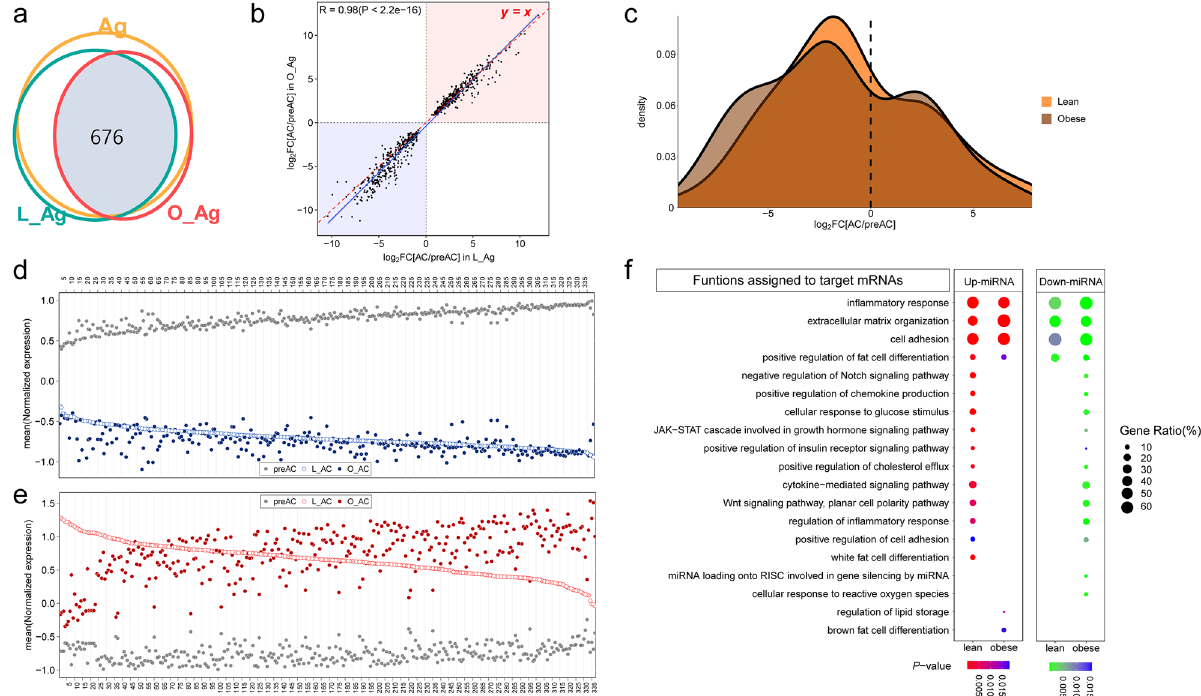
Figure 3. Analysis of DEMs commonly associated with both L_Ag and O_Ag. ( a ) Venn diagram depicting the number of common DEMs ( Q < 0.01 in both L_Ag and O_Ag). The yellow circle represents the Ag_DEMs, and the green and red circles represent the L_Ag-associated DEMs and O_Ag-associated DEMs, respectively. The light blue shaded region represents the overlapping area between each comparison group. ( b ) Scatter plot for common DEMs. The upregulated and downregulated DEMs are shaded red and blue, respectively. Log 2 FC values of miRNA expression changes in L_Ag (X-axis) were plotted against those in O_Ag (Y-axis). The red dashed line indicates the line of equality (Y = X). The regression line between the values is shown in blue, and the gray shadow reflects the 95% confidence interval. c. Density plot of Log 2 FCs of common DEMs; density of miRNAs in L_Ag (orange) and in O_Ag (brown). ( d ) Dot plot for the mean DESeq2-normalized expression level of the commonly downregulated DEMs ( n = 339). ( e ) Dot plot for the mean DESeq2-normalized expression level of the commonly upregulated DEMs ( n = 337). ( d , e ) The numbers on the X-axis correspond to the commonly downregulated DEMs and upregulated DEMs (only multiples of 5 are shown), respectively. The DEM information corresponding to each number on the X-axis is given in Additional files 4 and 5 (Tables S3 and S4). ( f ) Dot plot of the GO functional terms in which genes targeted by common DEMs for each comparison group are enriched. ‘Lean’ and ‘obese’ on the X-axis indicate genes targeted by DEMs assigned to ‘Lean_Strong’ and ‘Obese_Strong’,